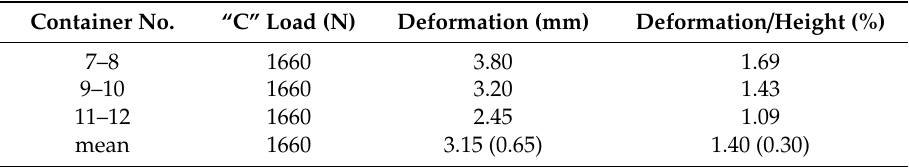
Table 5. Stacking test